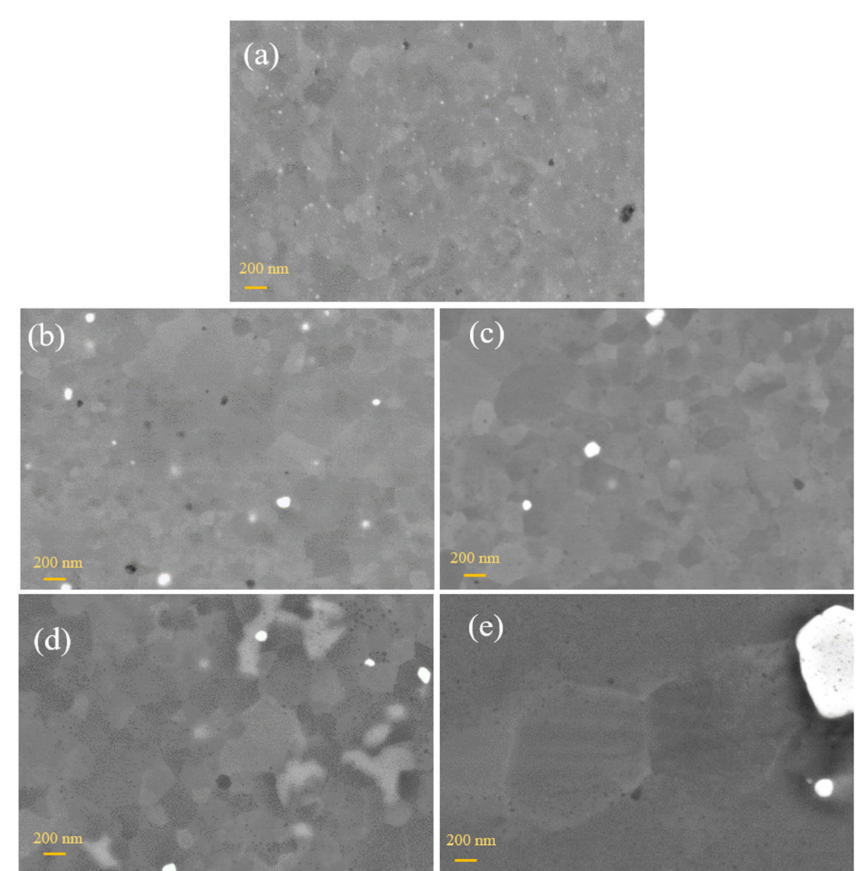
Figure 3. SEM images of OHP1 steel ( a ) as-rolled ( b ) and heat treated at 1000 ◦ C / 20 h, ( c ) 1100 ◦ C / 20 h,